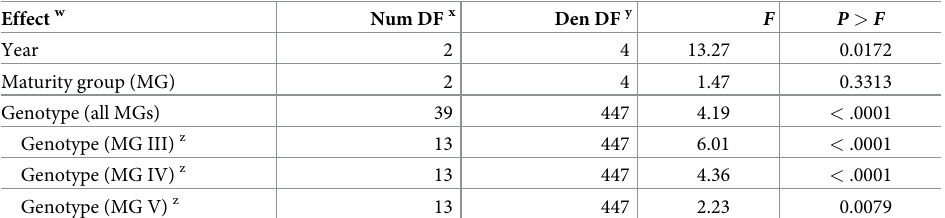
Table 3. F-test for fixed effects from analysis of variance of percentage of natural field seed infection by Cercos- pora species in Stoneville, Mississippi, in 2010, 2011, and 2012 v . Effect w Num DF x Den DF